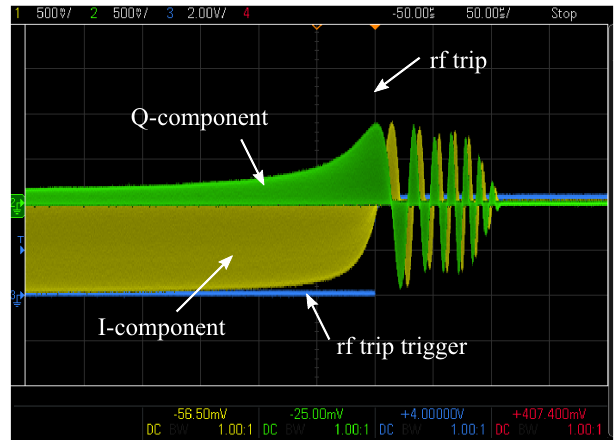
FIG. 5. Waveforms recorded with the oscilloscope 1 in Fig. 3 at the moment of beam dump. The yellow and green lines indicate the I and Q components of the beam signal, respectively. The blue line indicates the “ rf trip trigger ” signal, where high indicates the cutoff rf power, which triggered the recording. The scales are 500 mV = division (div.) for the I and Q signals, and 2 V = div. for the rf trip trigger in the vertical axis. The horizontal scale is 50 μ s = div. The sampling rate was 1